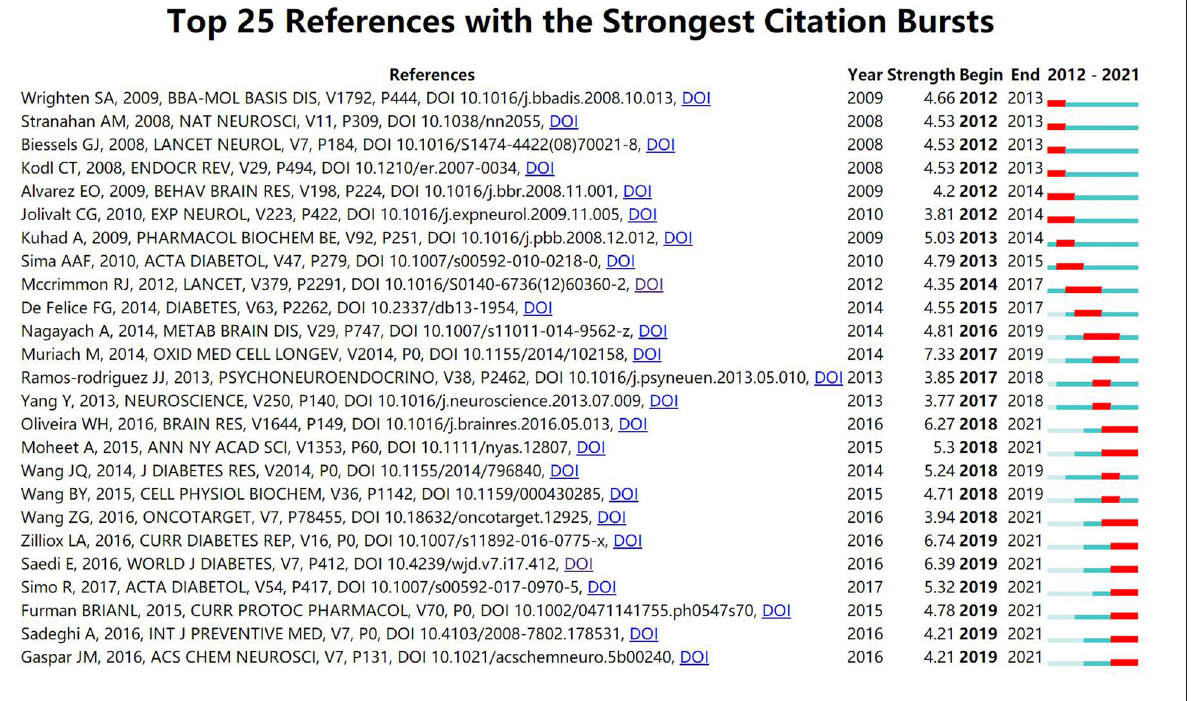
FIGURE4 The top 25 references with the strongest citation